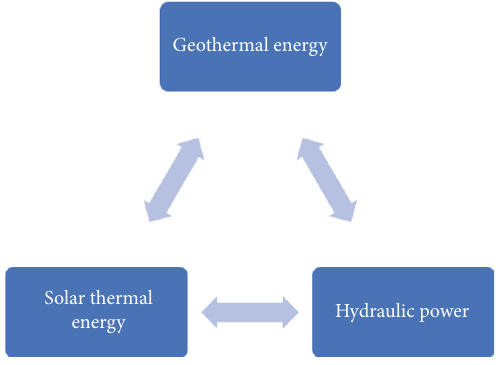
Figure 1: Important resources of renewable